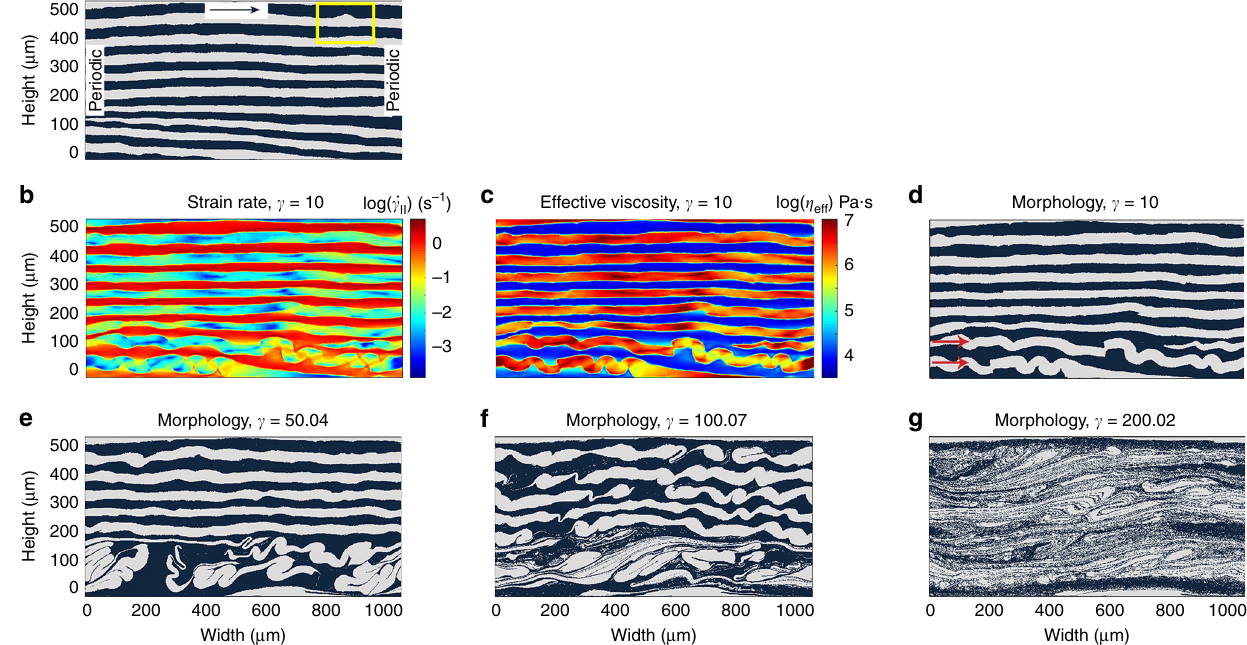
Fig. 3 Finite element simulation of shear deformation in a multilayer system. a The computational cell showing the initial arrangement of the layers and the direction of shear at the top. Black (lower characteristic viscosity) and white (higher characteristic viscosity) layers denote the two different phases in each experiment, and the model domain is comparable in size to that of the samples used in 3D X-ray synchrotron tomography experiments. The evolution of the yellow marked area is shown in Fig. 4a. b – g Simulation results for (VC = 10, n = 3). b – d Local strain rate ( _ γ ), effective viscosity ( η eff ), and morphology II maps at shear strain γ = 10, respectively. The arrows in d point to two folding layers. e – g Evolution of morphology with the increase of shear strain ( γ ) as indicated. See Supplementary Movies 3 – 5 for the dynamical evolution of morphology, strain rate, and effective viscosity maps,